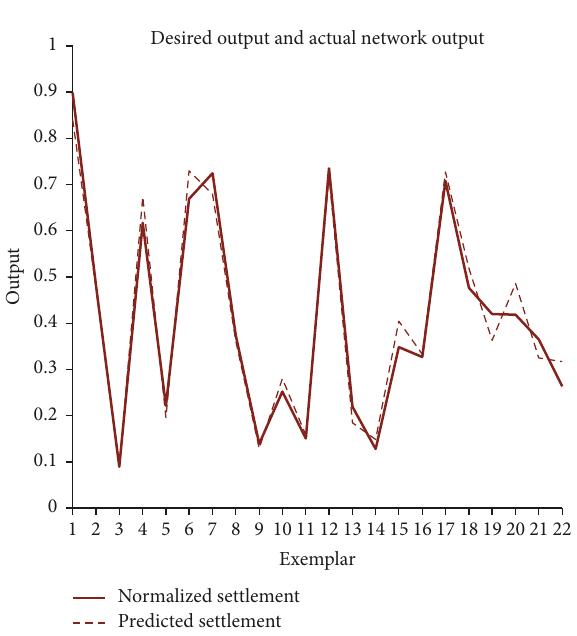
Figure 21: Predicted settlements versus calculated ones for the best static-dynamic neural network, 5-8-8-1.